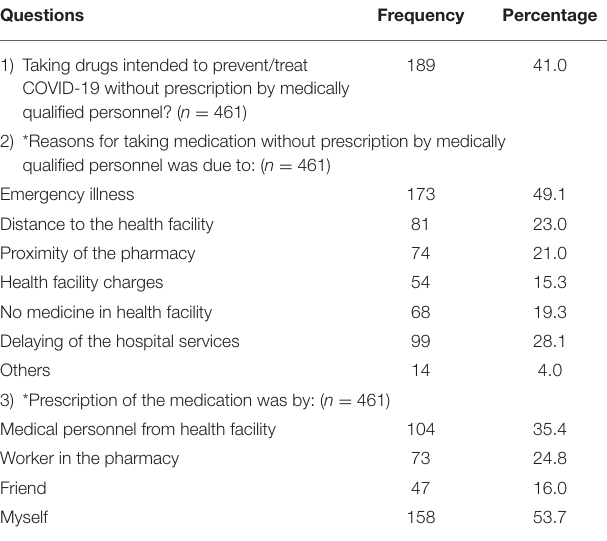
TABLE 2 | Self-medication